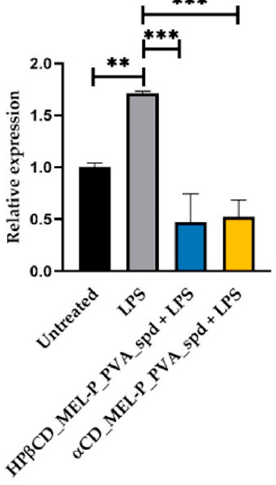
Figure 10. Relative expression of IL-6. (level of significance: ** p < 0.01, and *** p < 0.001)